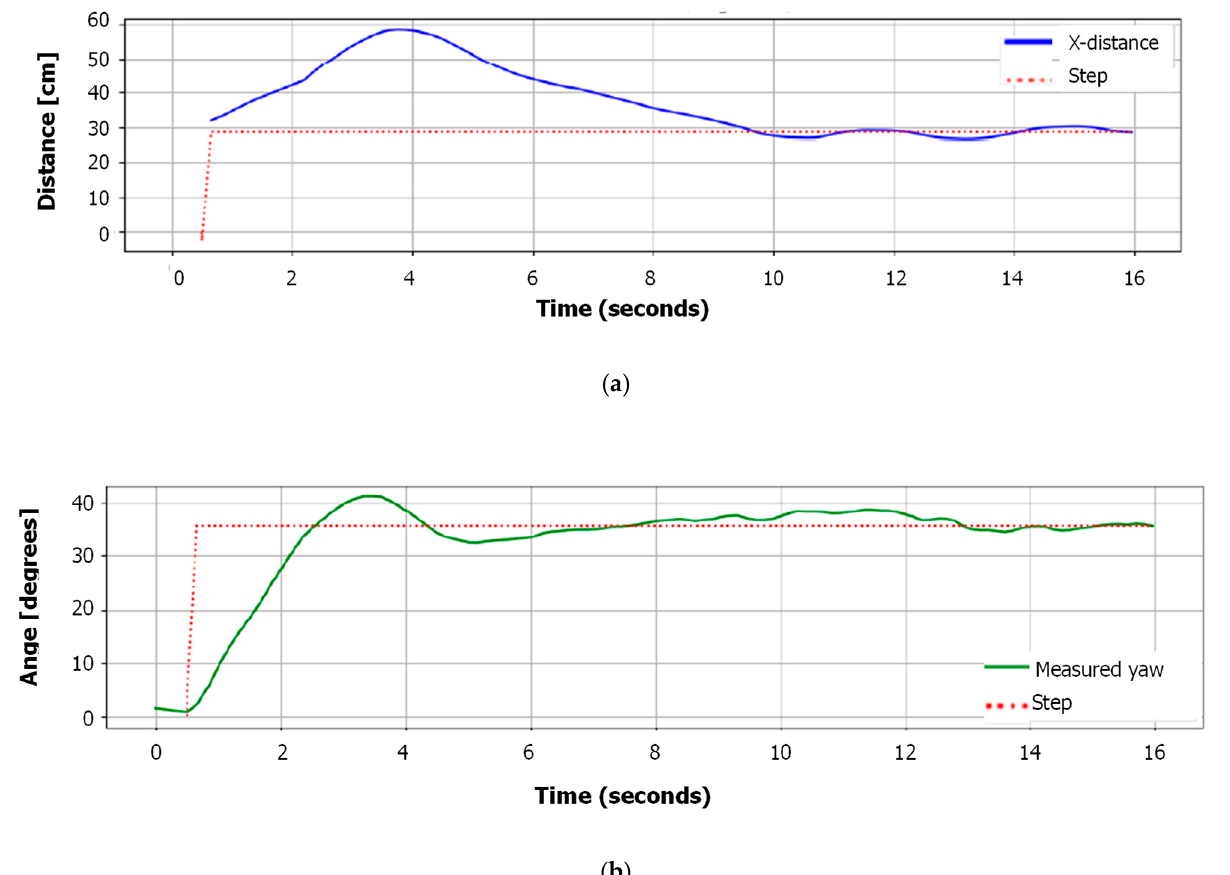
Figure 7. Experimental results: ( a ) x-direction controller; ( b ) yaw angle controller.